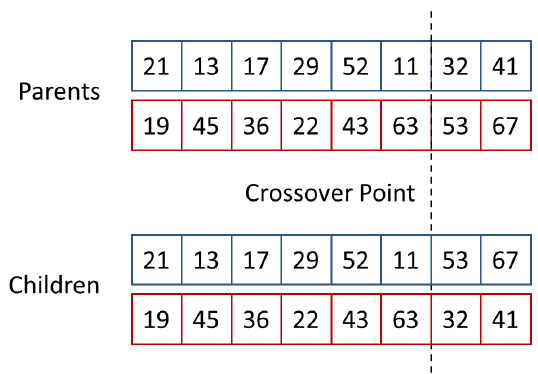
Figure 1. The one-point crossover operation. This figure presents the one-point reproduction operation where the information is mutually exchanged in a randomly chosen crossover point between two parent